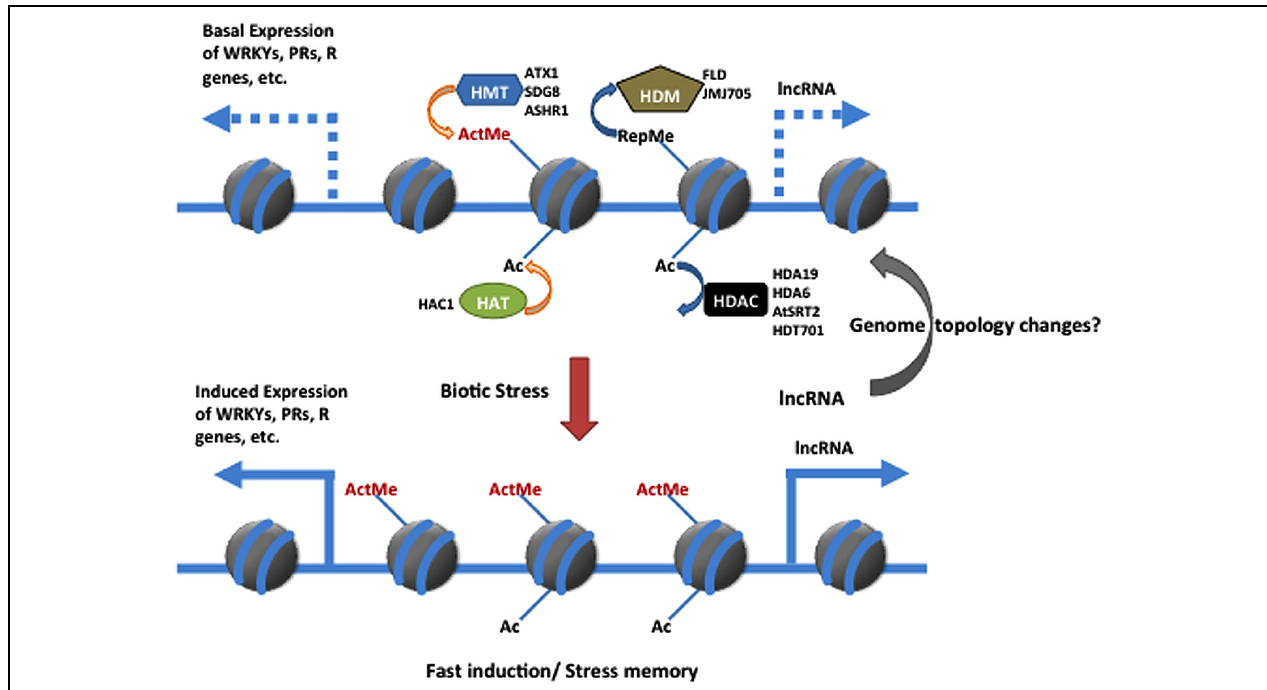
FIGURE 1 | Simplified model for participation of chromatin modification in regulating plant immunity against biotic stress. Histone modification changes in defense-related gene can be achieved through methylation/demethylation and/or acetylation/deacetylation by antagonistic interaction between HMT and HDM or HAT and HDAC Each enzymes catalyzed different modification in regarding its roles in plant immunity is described in literature. The hypothetical involvement of the IncRNA in regulating the dynamin defense gene expression through the modulation of chromatin architecture is proposed as well. ActMe, active methylation marker; RepMe, Repressive methylation marker; HMT, histone methyltransferase; HDM, histone demethylase; HAC, histone acetylase; HDAC, histone de acetylase; IncRNA, long non-coding RNA; PR, pathogenesis-related; R, Resistance.